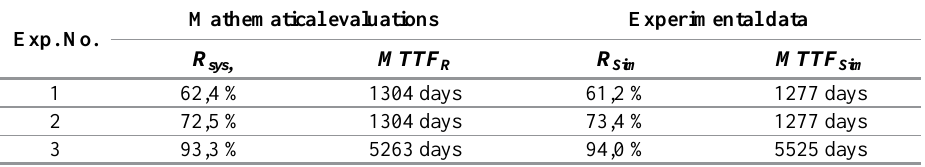
table 4. Reliability evaluation results exp.